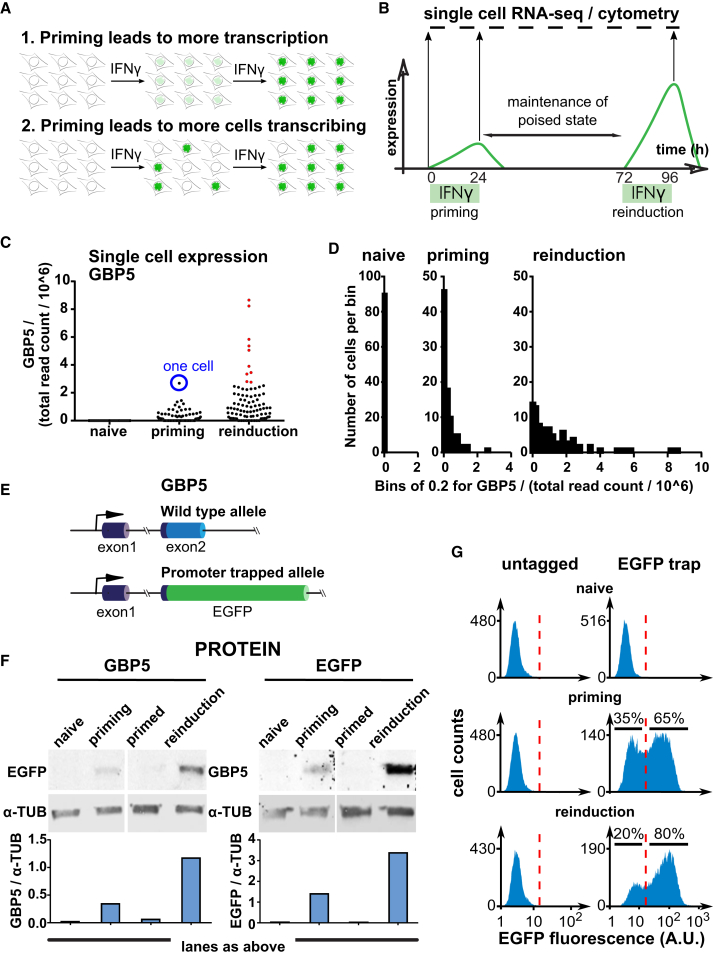
Priming Results in Increased Frequency of Activation and Enhanced GBP5 Expression upon Reinduction(A) Alternative solutions for achieving IFNγ transcriptional memory.(B) Scheme describing a single-cell RNA-seq transcriptional memory experiment to distinguish between the alternatives from (A).(C) Representation of the single-cell RNA-seq data from HeLa cells for the GBP5 gene from the experiment shown in (B). Each dot represents the expression level of the GBP5 gene for one cell in the naive (N = 90), priming (N = 89), and reinduction state (N = 91).(D) Binned representation of the single-cell RNA-seq data for the GBP5 gene from the experiment shown in (C).(E) Scheme outlining the GBP5 promoter trap cell line, in which EGFP was inserted into exon 2 downstream of the GBP5 translation start site. One allele was targeted, and the remaining allele remained unperturbed. Purple, 5′ UTR; blue, GBP5 coding sequence.(F) EGFP::GBP5 cells were subjected to the IFNγ treatment regimen outlined in Figure 1B, processed for fluorescence western blotting, and probed for GBP5 and EGFP expression. α-TUB, loading control. Tubulin-normalized fluorescence intensities are plotted.(G) EGFP::GBP5 cells were subjected to the IFNγ treatment regimen as outlined in (B) and processed for cytometry. Cell frequencies as a function of EGFP fluorescence intensity are plotted. Red dotted lines are fiducial marks based on untagged cells and are used to define the cutoff for cell percentages expressing or not expressing.See also Figure S2.